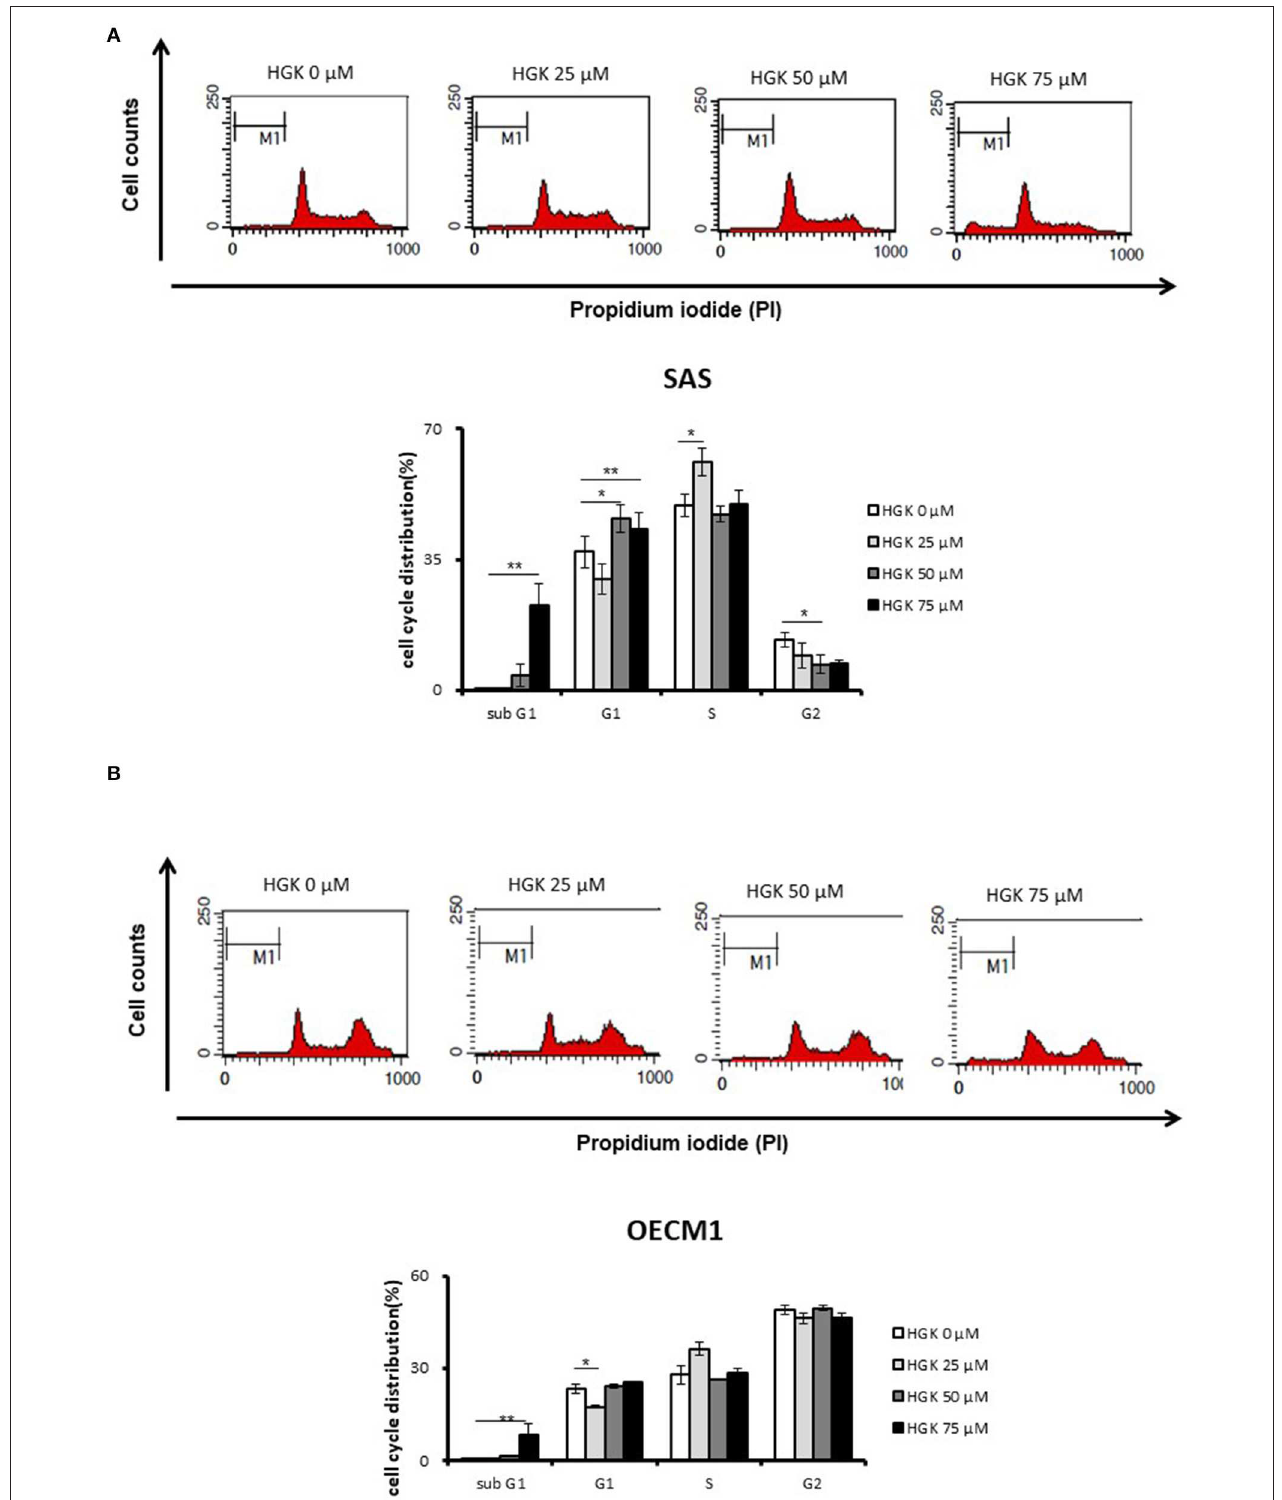
FIGURE 4 | Effects of HGK on the cell cycle progression in SAS and OECM1 cells. SAS cells (A) and OECM1 cell (B) were treated with 0, 25, 50, 75 µ M for 24h. The results are shown as the mean ± S.E. of three independent experiments. * P < 0.05 and ** P < 0.01.